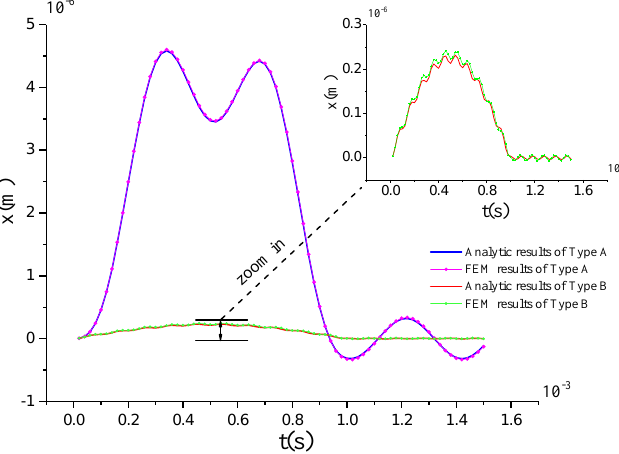
Figure 16. Analytic and FEM results of Type-A and